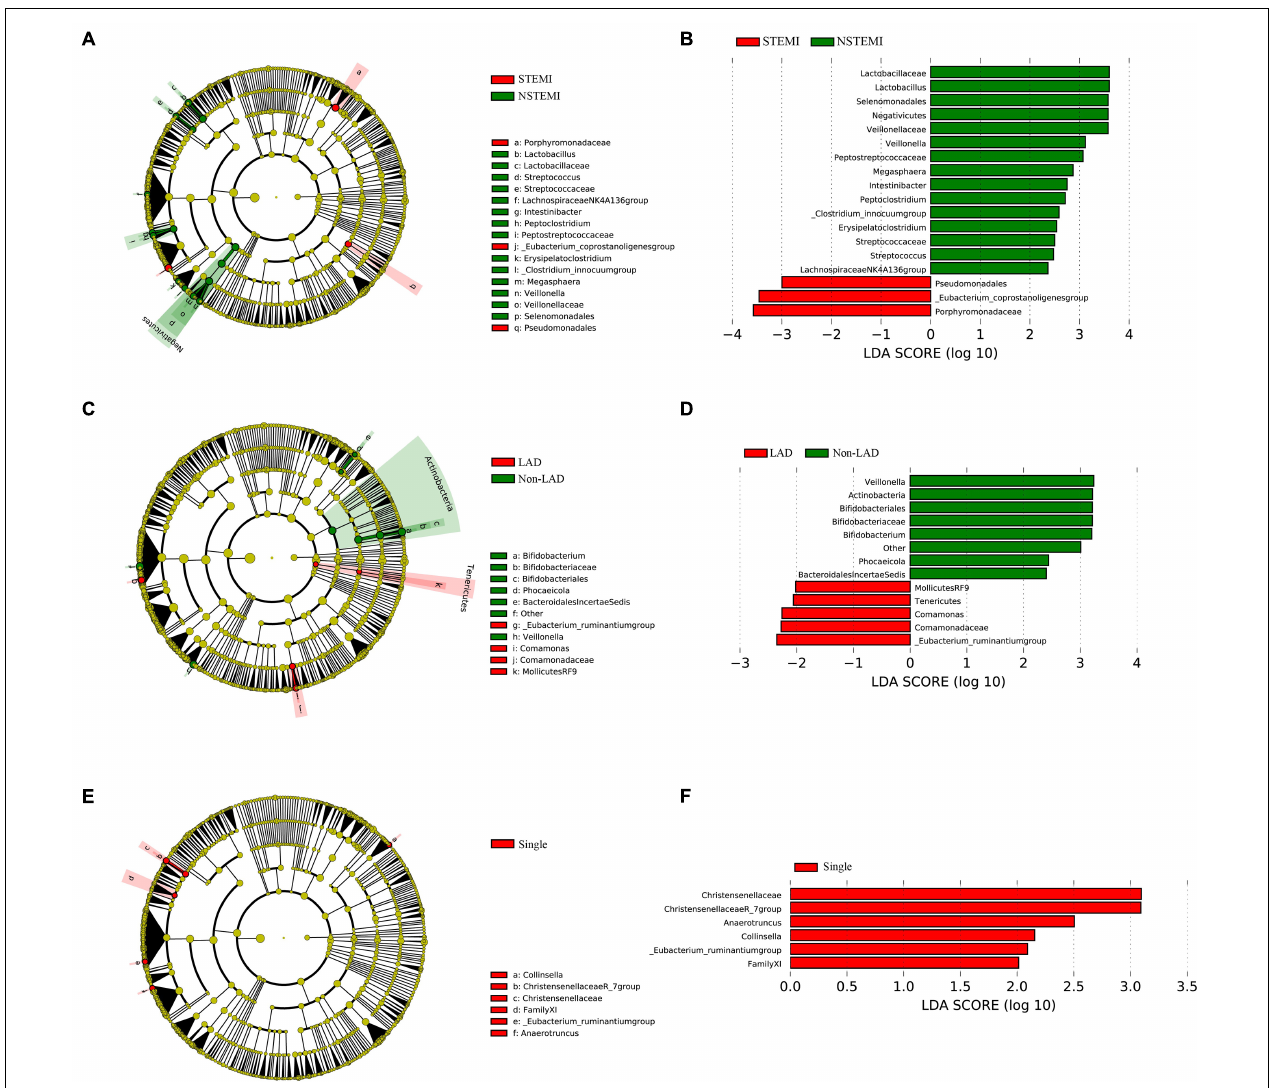
FIGURE 4 | The difference expression of gut microflora between the subgroups in patients with AMI. (A,B) Shows the different abundances of gut microflora between the STEMI group and the NSTEMI group; (C,D) shows the different abundances of gut microflora in the patients with LAD as the IRA compared to the IRA-Non-LADs; (E,F) shows the different abundances of gut microflora in the Single coronary stenosis group than in the Multiple ( ≥ 2 coronary stenosis) group. STEMI, ST-elevation myocardiol infarction; NSTEMI, Non ST-elevation myocardiol infarction; IRA, Infarction related artery; LAD, left anterior descending